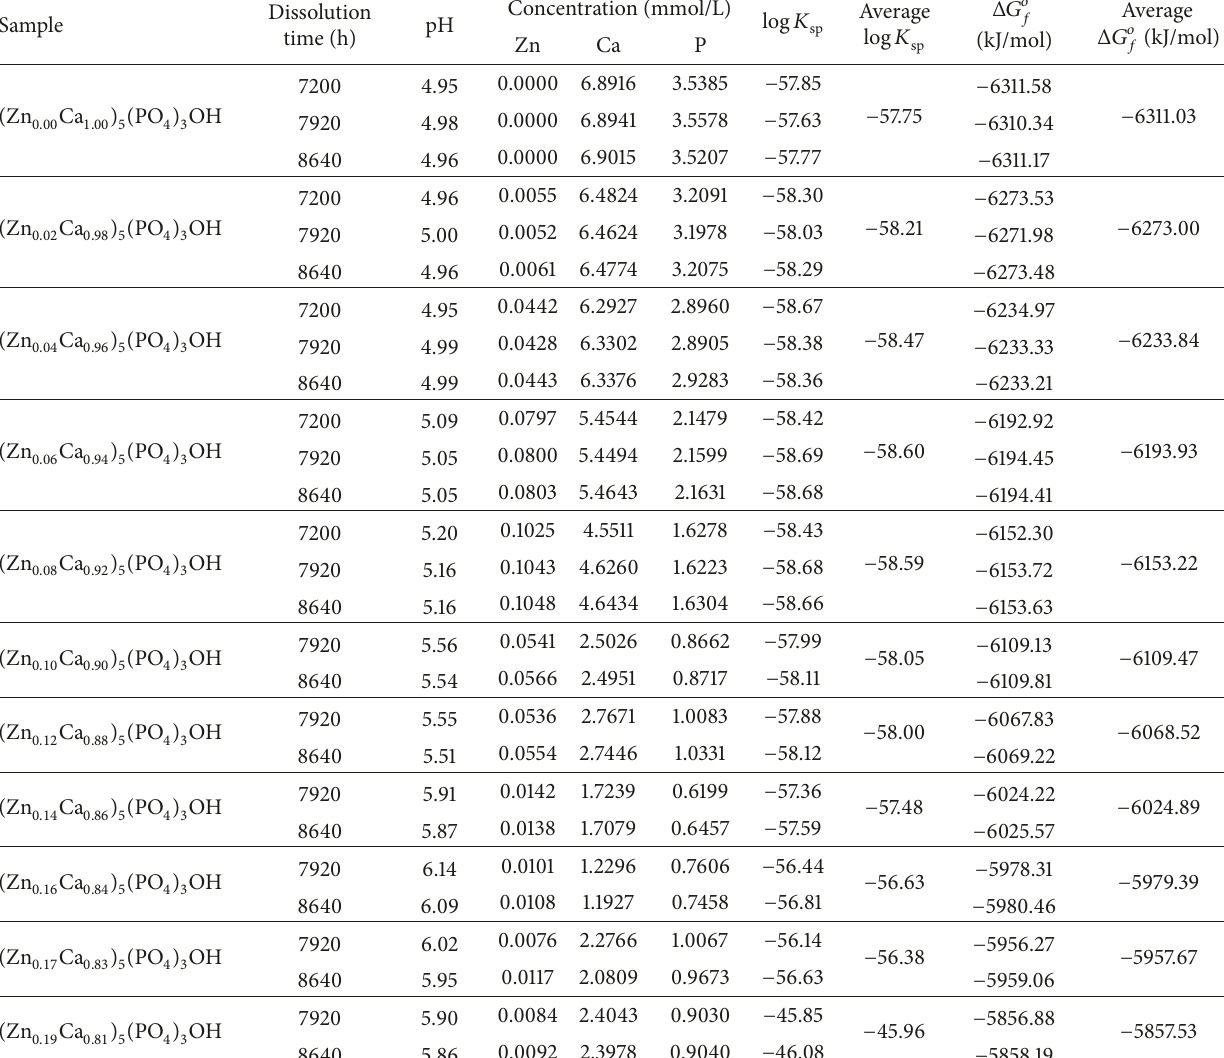
Table 2: Analytical data and solubility determination of the Zn-substituted hydroxylapatites (25 ∘ C and initial pH 2.00).